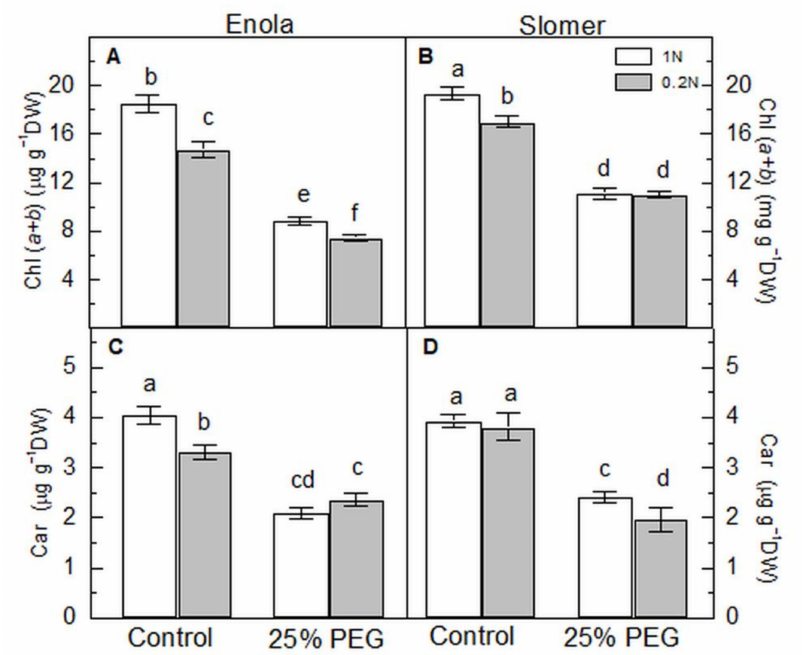
Figure 5. Leaf pigment content: total chlorophyll (Chl a + b ) ( A , B ) and carotenoids (Car) ( C , D ) of two wheat varieties (Enola and Slomer) grown with optimal (1 N) and reduced (0.2 N) nitrogen supply and subjected to osmotic stress with 25% PEG. Different letters represent significant differences at p < 0.05 ( n = 8).